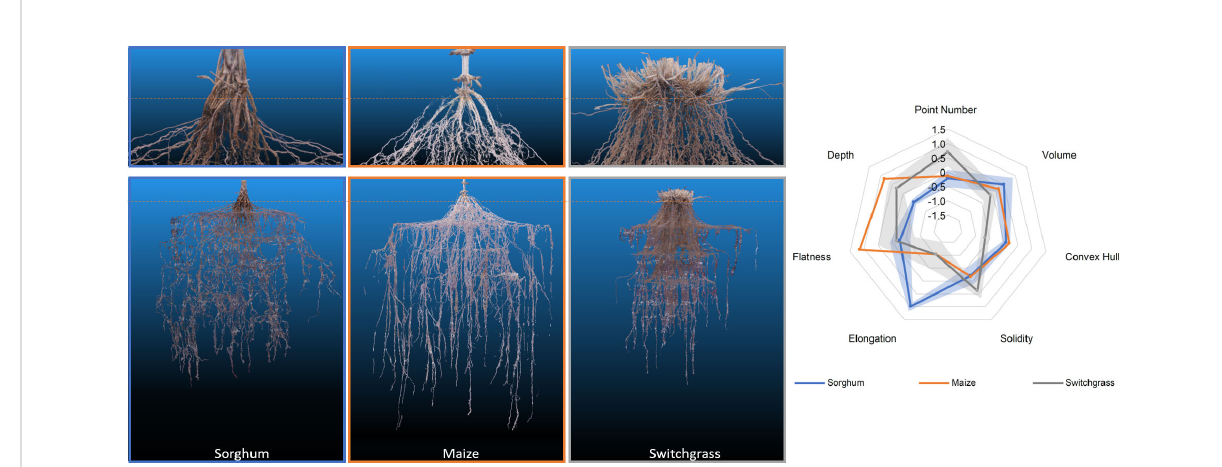
FIGURE 7 RSA of 3 different mesocosm grown species (left). Representative point clouds for sorghum, maize, and switchgrass species. Orange dotted line denotes the approximate growth media level during growth. A radar plot detailing the analysis of 7 different root shape traits from the point clouds. Data shown are mean ± standard error in shaded regions. Sorghum and switchgrass n=3, maize